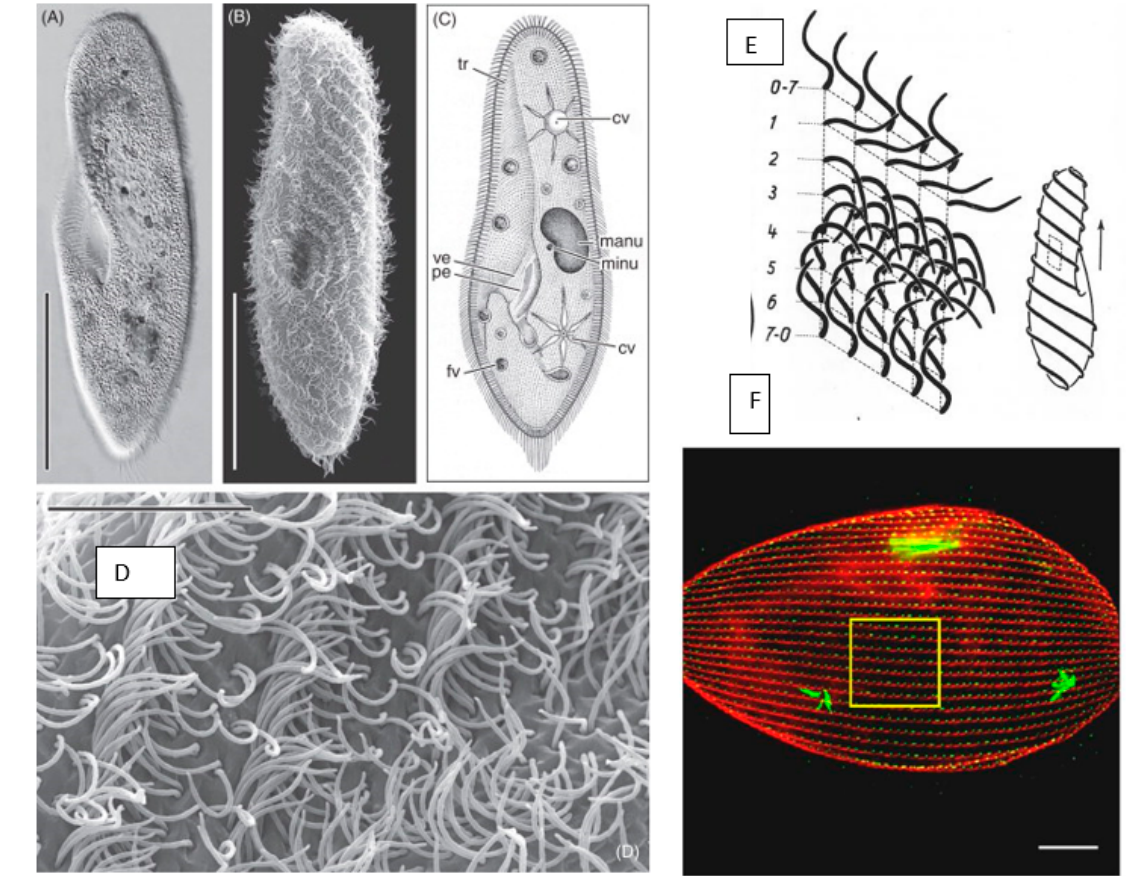
Figure 1. Panel 1 ( A , B ): light microscopic appearance of Paramecium caudatum . Panel 1 ( C ): drawing of Paramecium illustrating light microscopic features: cv contractile vacuoles, fv food vacuoles, manu macronucleus, mino micronucleus, pe peristome, tr trichocysts and ve vestibulum. Panel 1 ( D ): higher magnification of the metachronal waves of the cilia. Scale bar in ( A ) and ( B ) 100 µm; ( D ) 10 µm. from Figure 1 in [29] and used with permission. Panel ( E ): form of ciliary stroke and metachrony. Diagrams of instantaneously fixed surface area with five ciliary rows with 0–2 effective, 2–7 recovery stroke. Cell diagram at left shows source of metachronal waves in forward movement. From Grell [32] and used with permission. Panel ( F ): immunofluorescence image of P. tetraurelia. Basal bodies green (1D5 antibody) and striated rootlets of the basal bodies red (anti-–SR). Straight rows extend between the anterior and posterior poles. [33]; used with permission.